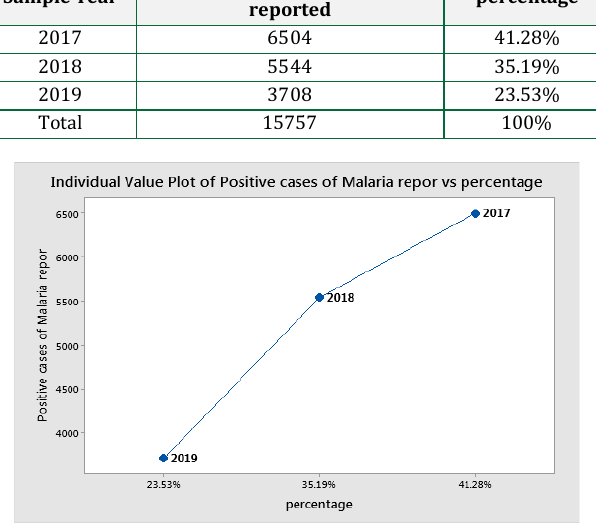
Figure 7: One-way ANOVA at 0.05 significant levels for 3